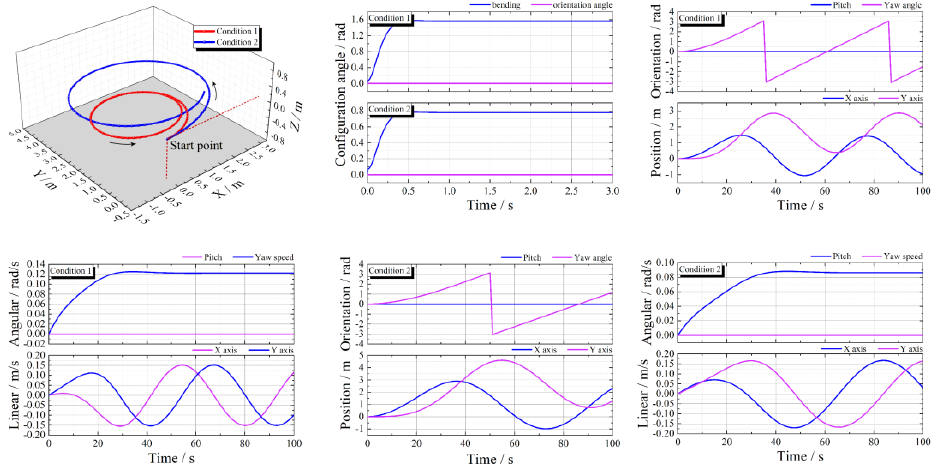
Figure 11. Simulation tests for yaw turning motion under different conditions, which contain the trajectories under conditions 1 and 2, configurations of soft joints, position and orientation under condition 1, linear and angular velocity under condition 1, position and orientation under condition 2, and linear and angular velocity under condition 2.